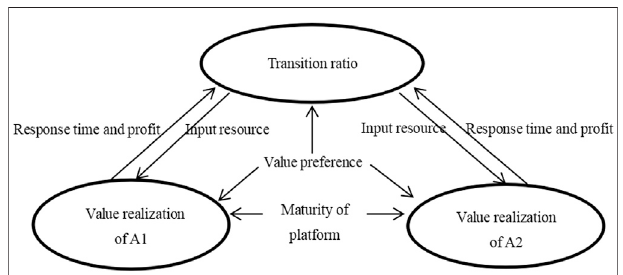
FIGURE 2 | General structure.